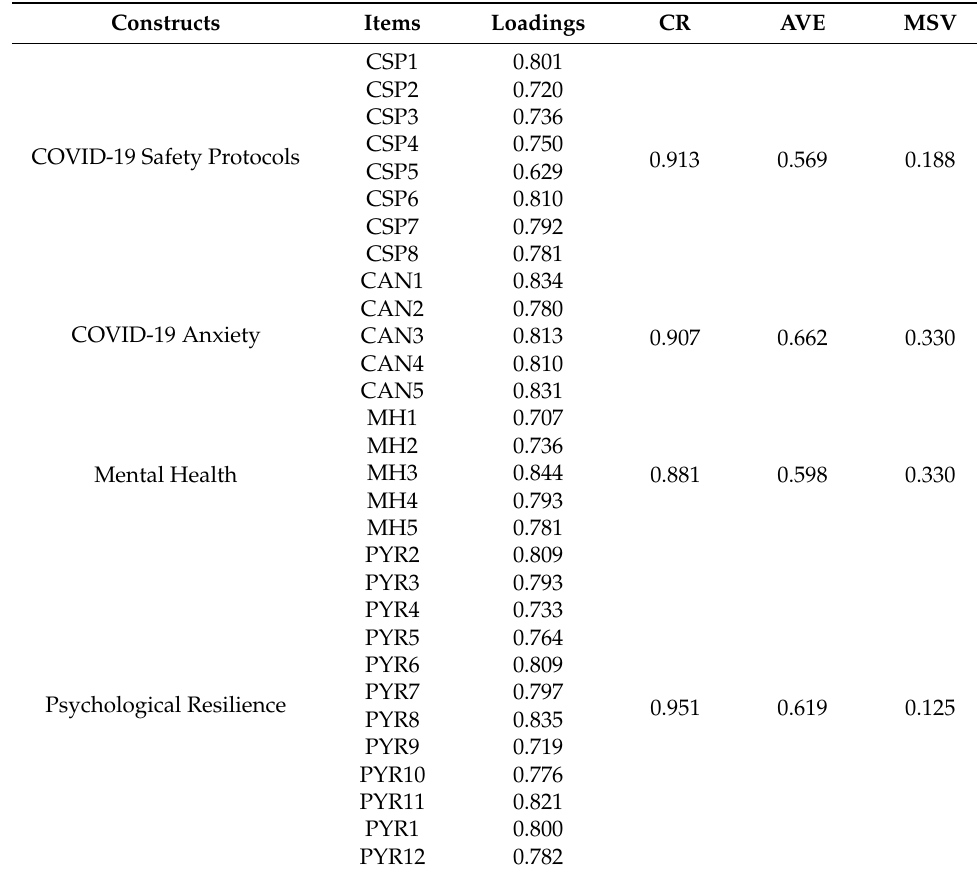
Table 3. Convergent validity.